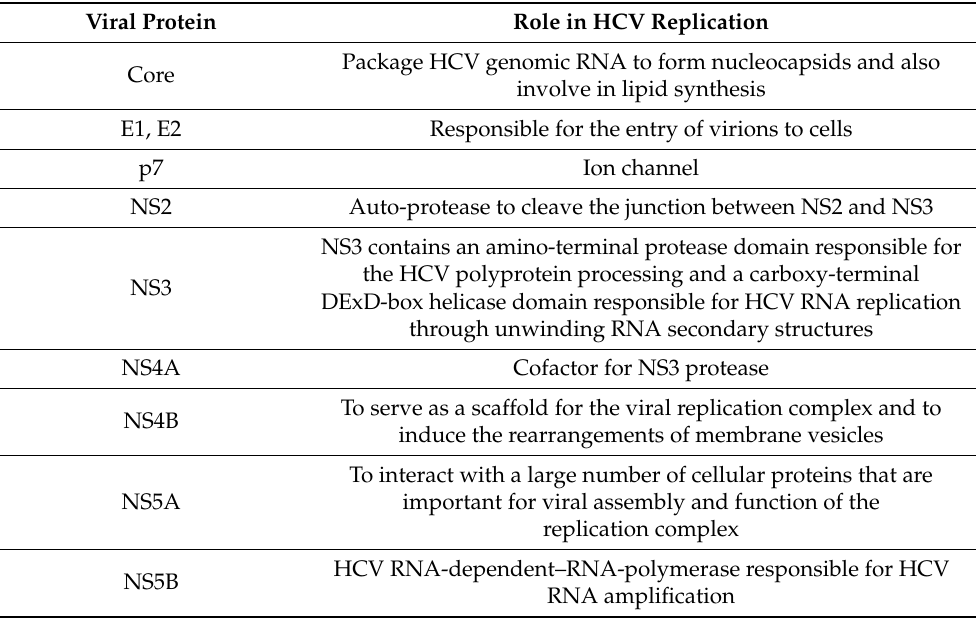
Table 1. Hepatitis C virus (HCV) proteins play different roles in viral